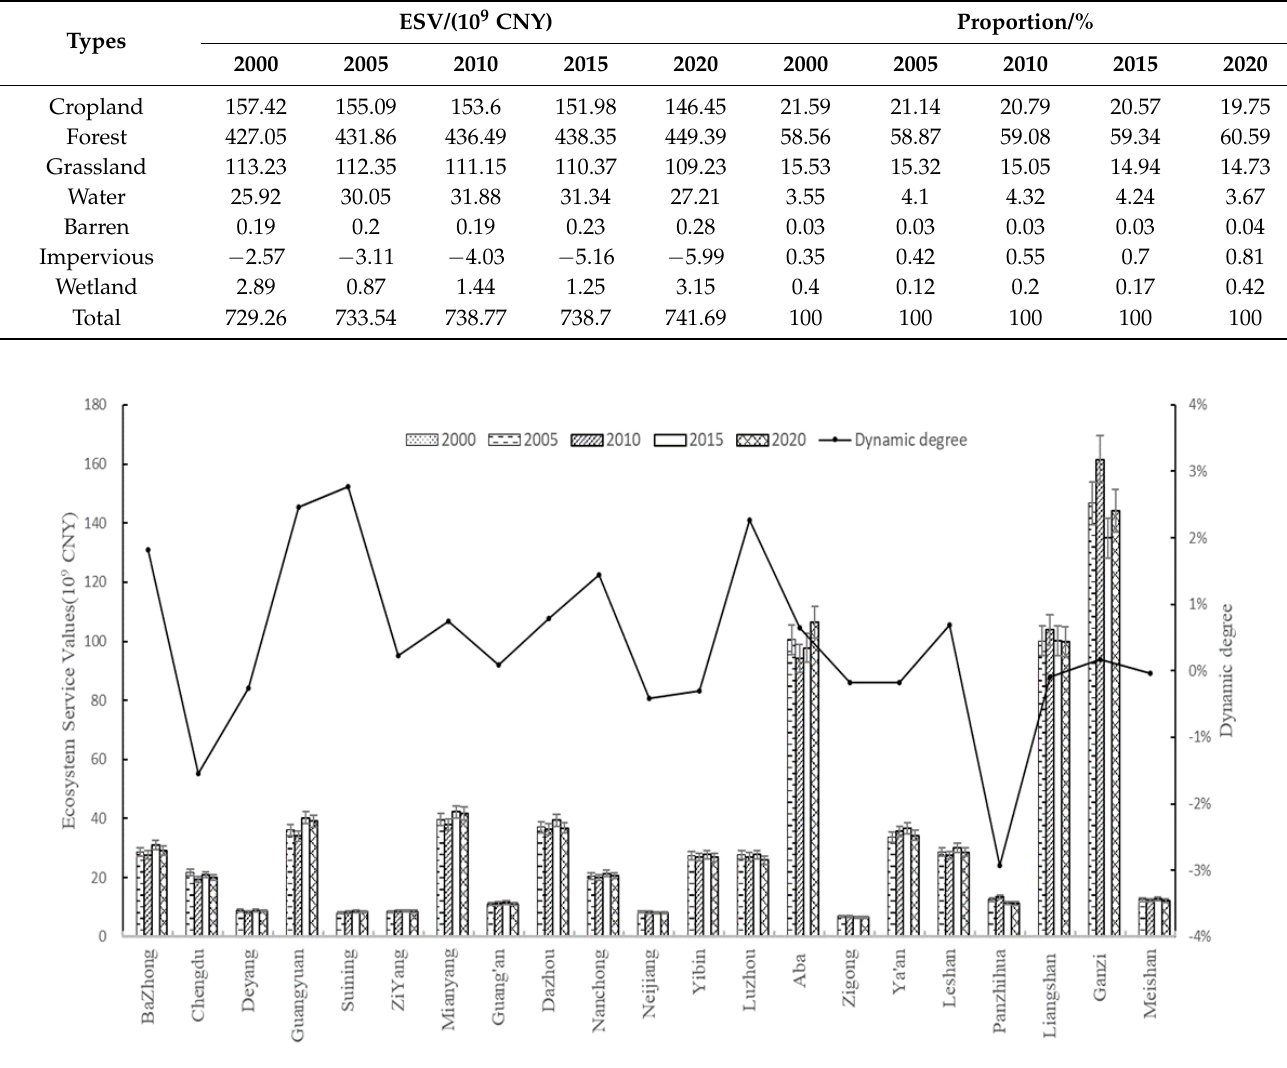
Figure 3. The value and dynamics of ecological waiters in various cities (autonomous regions) in Sichuan Province from 2000 to